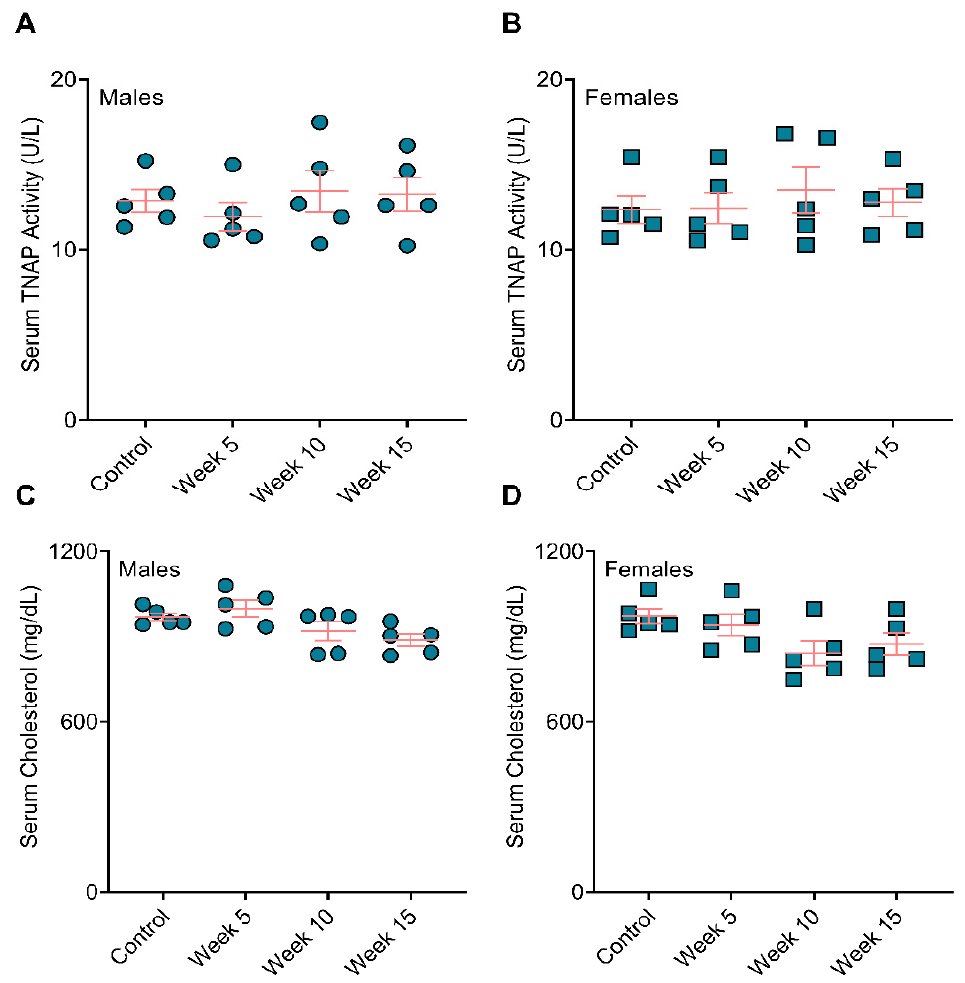
Figure 5. BiP treatment did not affect the serum TNAP activity and total cholesterol in mouse model of atherosclerotic plaque calcification. Serum TNAP activity in ( A ) male mice and ( B ) female mice; serum total cholesterol in ( C ) male mice and ( D ) female mice. No statistically significance observed across the groups, two-way ANOVA with Tukey’s post-hoc